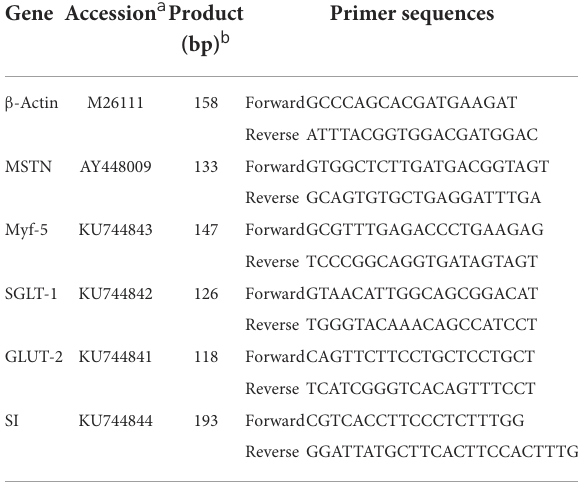
TABLE 2 Primers used for quantitative real-time